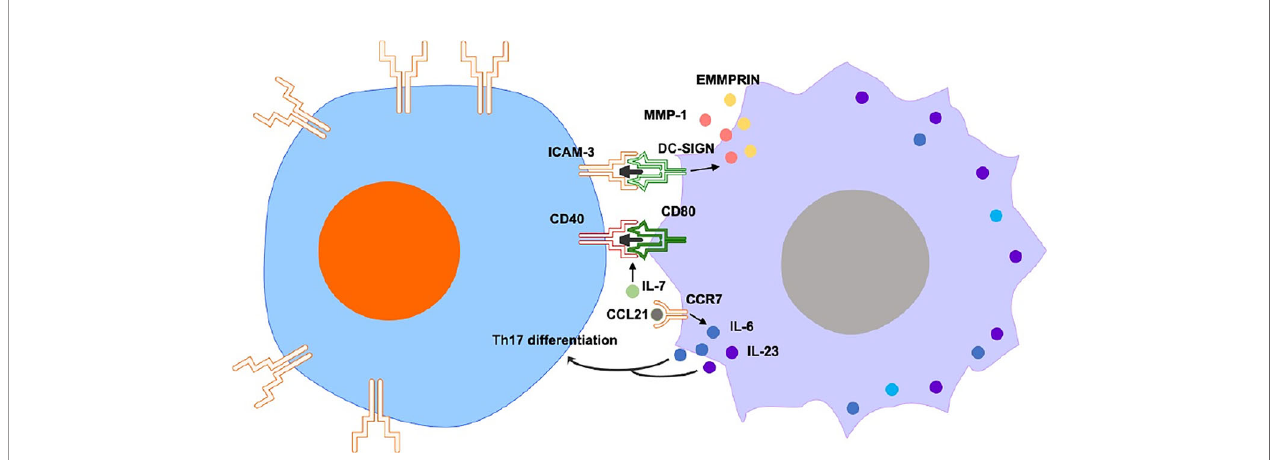
FIGURE 3 | Mutual interaction between macrophages and T cells includes ICAM3/DC-SIGN, CD40/CD80 and CCL21/CCR7-Th17. The interaction of macrophages/T cells via DC-SIGN/ICAM-3 promotes the additional activation of synovial macrophages and production of EMMPRIN and MMP-1. IL-7 promotes co- stimulatory molecules CD80 and CD40 on CD14+ monocytes in the presence of CD4+ T cells. In the early stages of RA, CCL21-induced M1 cytokines favor the differentiation of naïve T cells into Th17 cells. In the erosive stages of RA, CCL21 aggravates RA osteoclastogenesis via M1 macrophages-mediated Th17